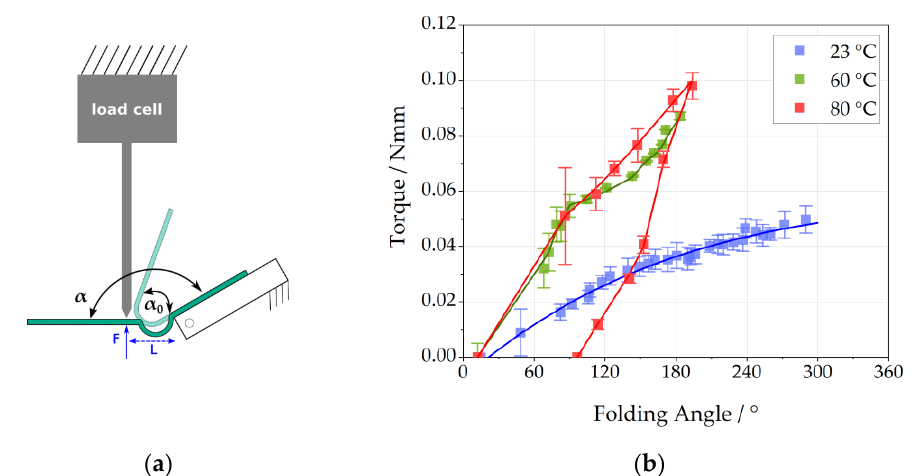
Figure 8. Measurement of blocking force versus folding angle of a single self-folding microactuator at different temperatures: ( a ) schematic of experimental setup; ( b ) torque-folding angle characteristics for different average temperatures of the microactuator.